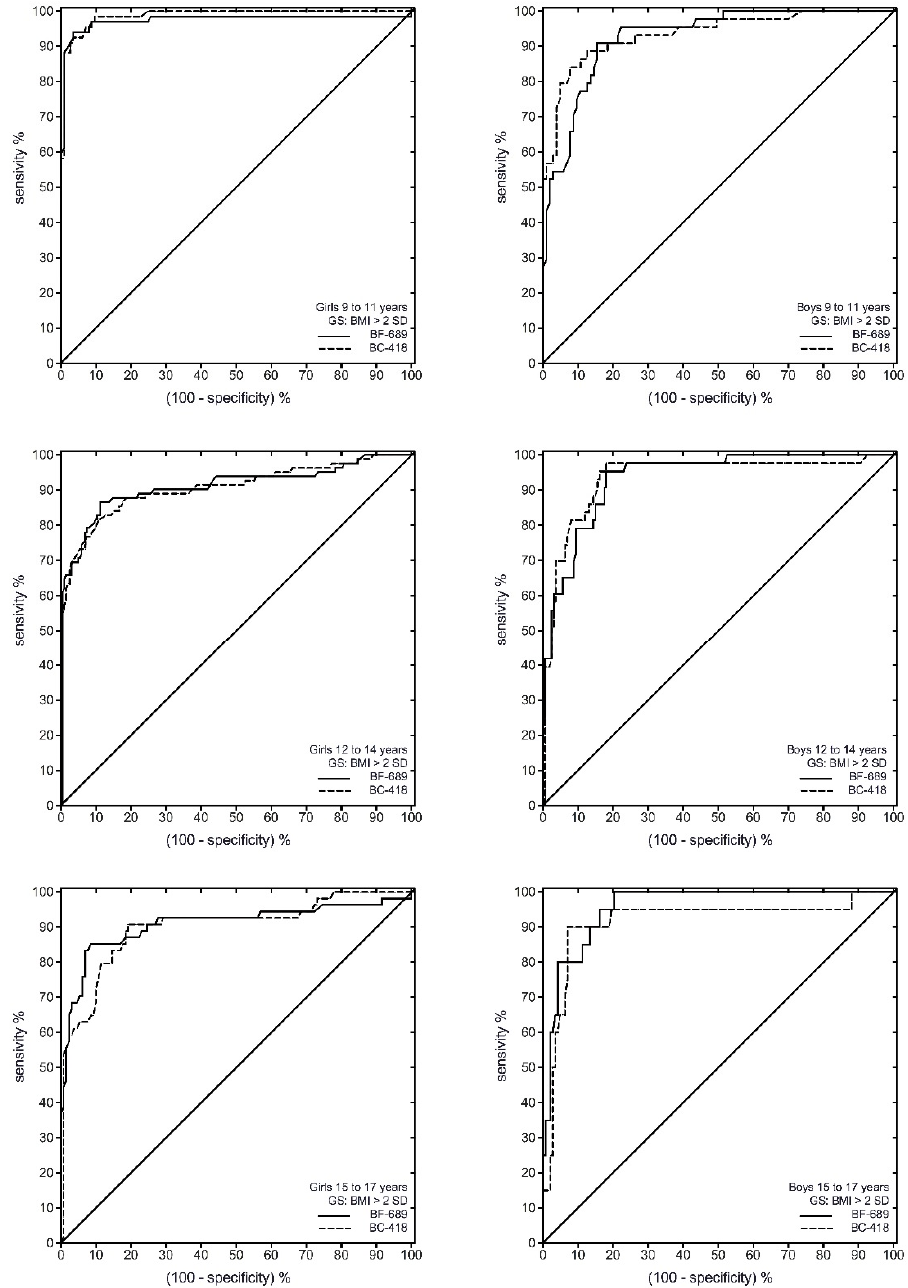
Figure 1. Receiver operating characteristic (ROC) curve of the BF% for ability to correctly classify children as overweight/obesity ( ≥ 2SD) defined by IOTF between Tanita BC-418 ® and Tanita BF-689 ® among Colombian children and adolescents. GS, gold standard.